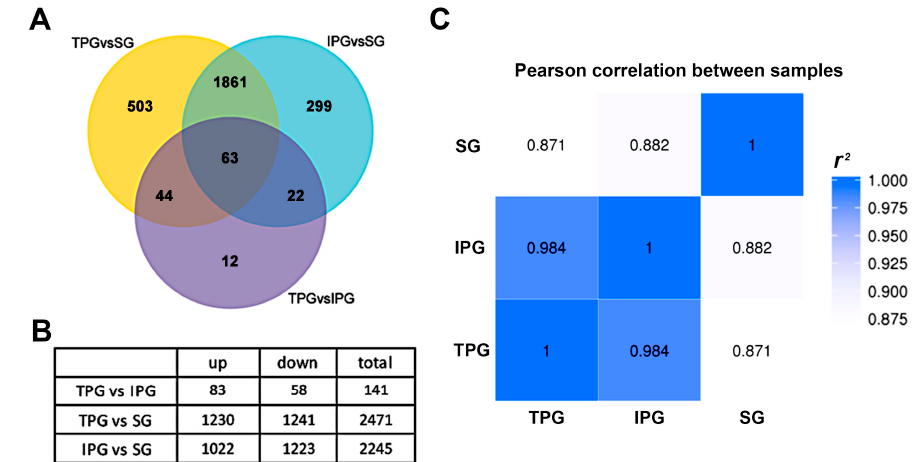
Figure 2. Analysis on RNA-seq results based on the RNA-extraction from Arabidopsis roots of three different conditions. ( A ) A Venn diagram shows the numbers of DEGs identified from the total RNA extracted from the roots of soil-growing (SG), traditional plant-growing culture system (TPG), and the improved plant-growing method (IPG). ( B ) The number of up- and downregulated genes from three comparison groups. ( C ) The Pearson correlation analysis between the gene expression pattern of the three different